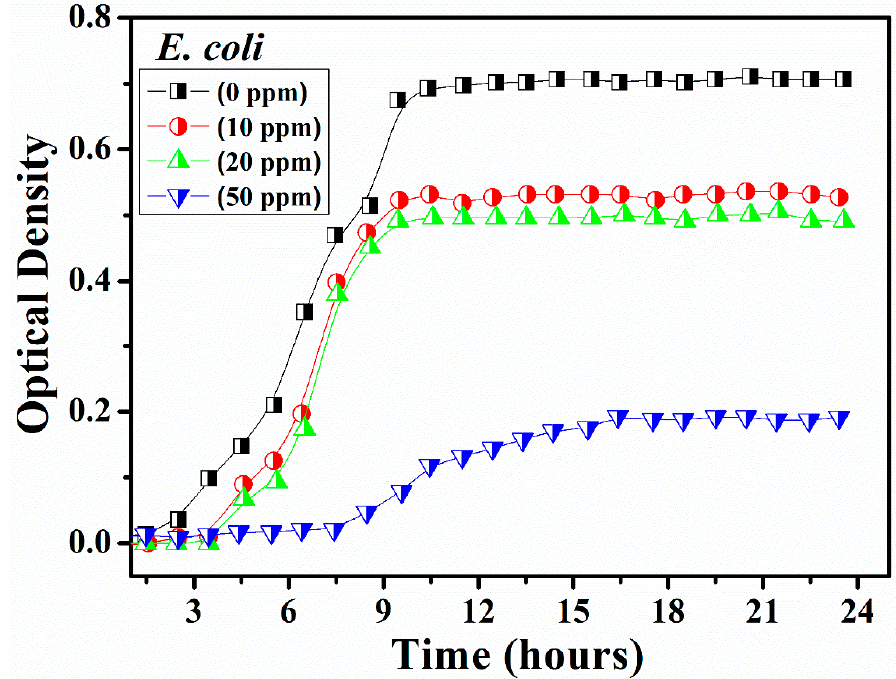
Figure 6. Optical densities as a function of time of E . coli in the presence of CeO 2 NPs.